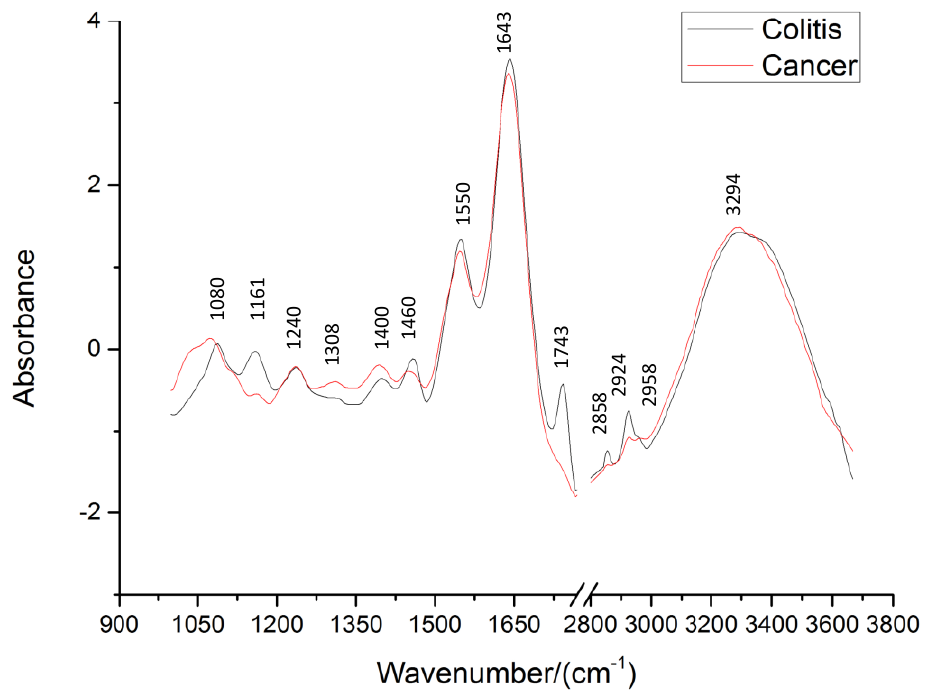
Figure 2. The typical FTIR spectra of colorectal biopsies after preprocessing.